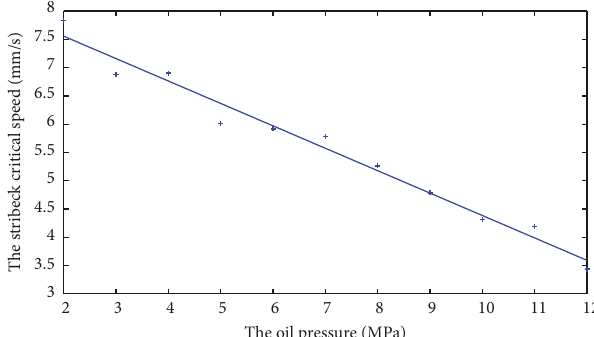
Figure 17: Effect of pressure change on the Stribeck critical